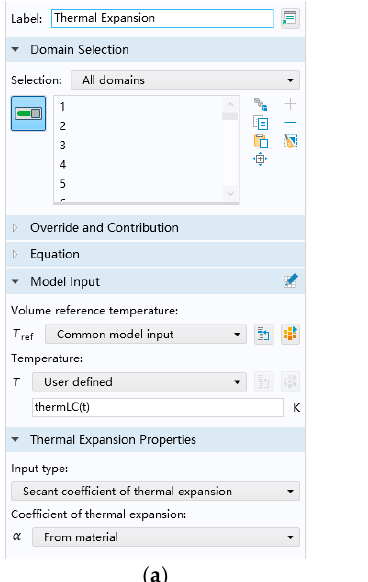
Figure 6. The settings of ( a ) boundary constraint; ( b ) finite element analysis.